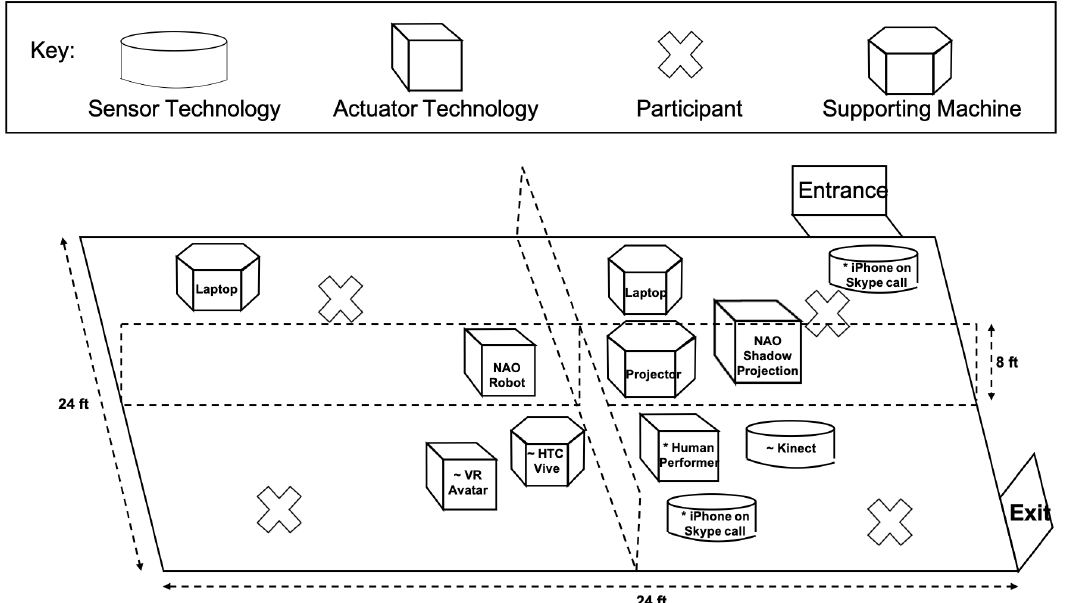
Figure 4: The various nodes of the installation experience. Elements that are connected during the installation or that are interacting with each other are indicated here through the same symbol beforehand (for example, HTC Vive, VR Avatar, and Kinect all preceded by a tilde). Participants moved in a counterclockwise direction through the four quadrants, from entrance to exit, with their general position in the space indicated by an X in each